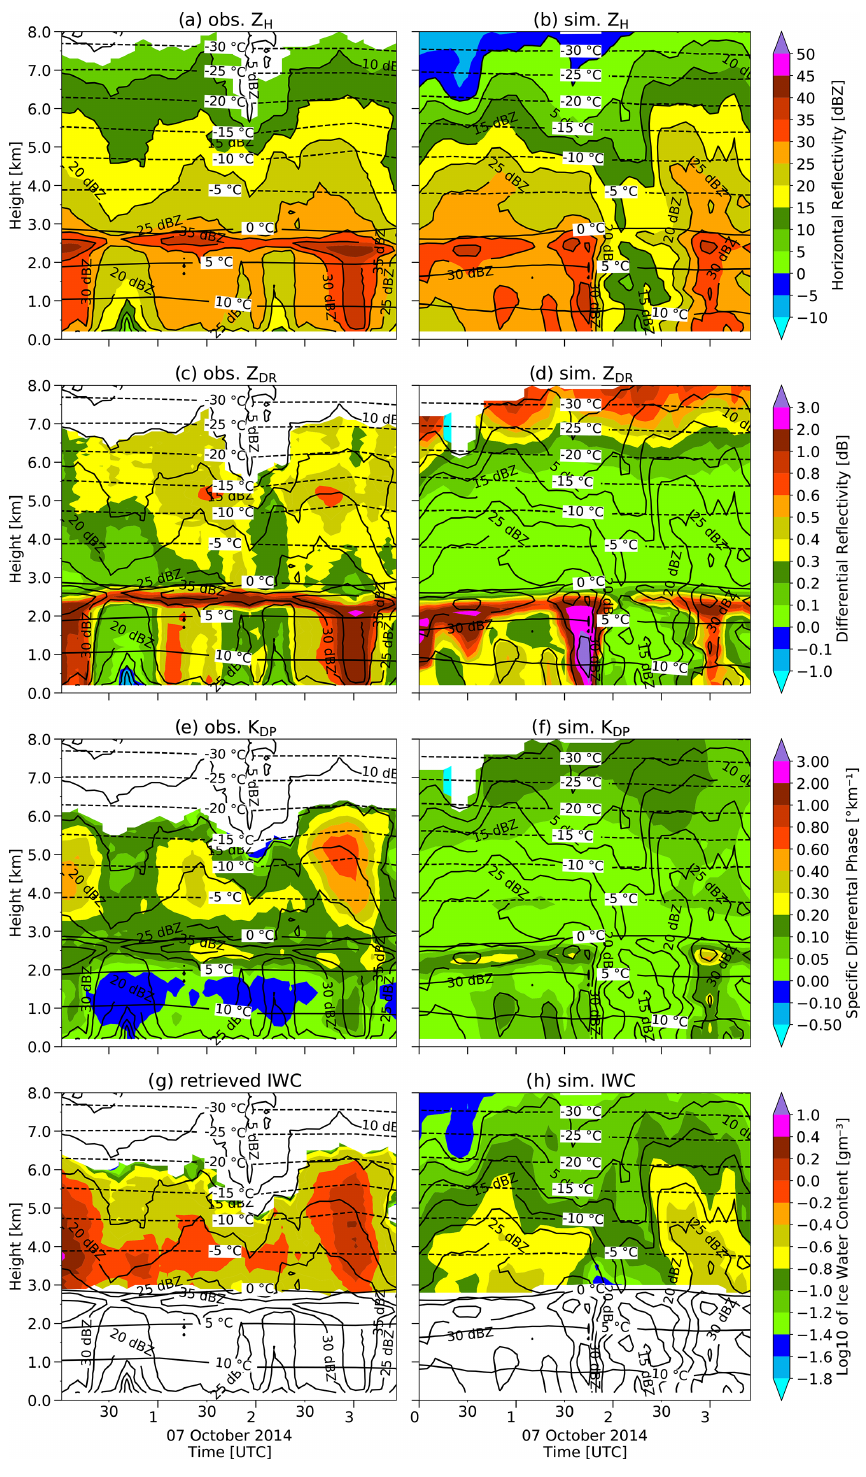
Figure 7. Quasi-vertical profiles (QVPs) of observed (left column) and simulated (right column) polarimetric radar variables’ horizontal reflectivity Z H (a, b) , differential reflectivity Z DR (c, d) , and specific differential phase K DP (e, f) together with radar-retrieved (g) and simulated ice water content (IWC, h ). The QVPs show a stratiform rain event observed on 7 October 2014 between 00:00 and 03:30UTC with the polarimetric X-band radar in Bonn, BoXPol, and simulated with COSMO version 5.1 and the two-moment cloud microphysics